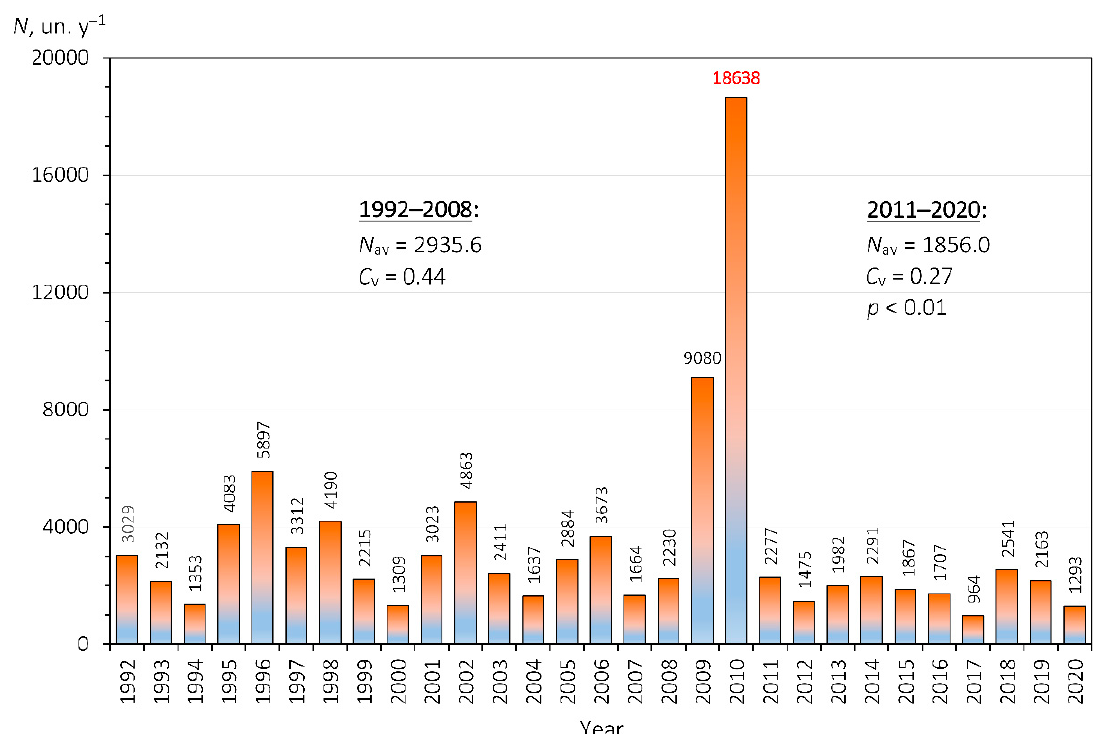
Figure 3. The number of forest fires per annum ( N ) in the Volga Federal District during 1992–2020. N av —the average value of N for the corresponding observation period; C v —the coefficient of variation of N ; p —the probability of a statistically significant difference between the averages of 1992–2008